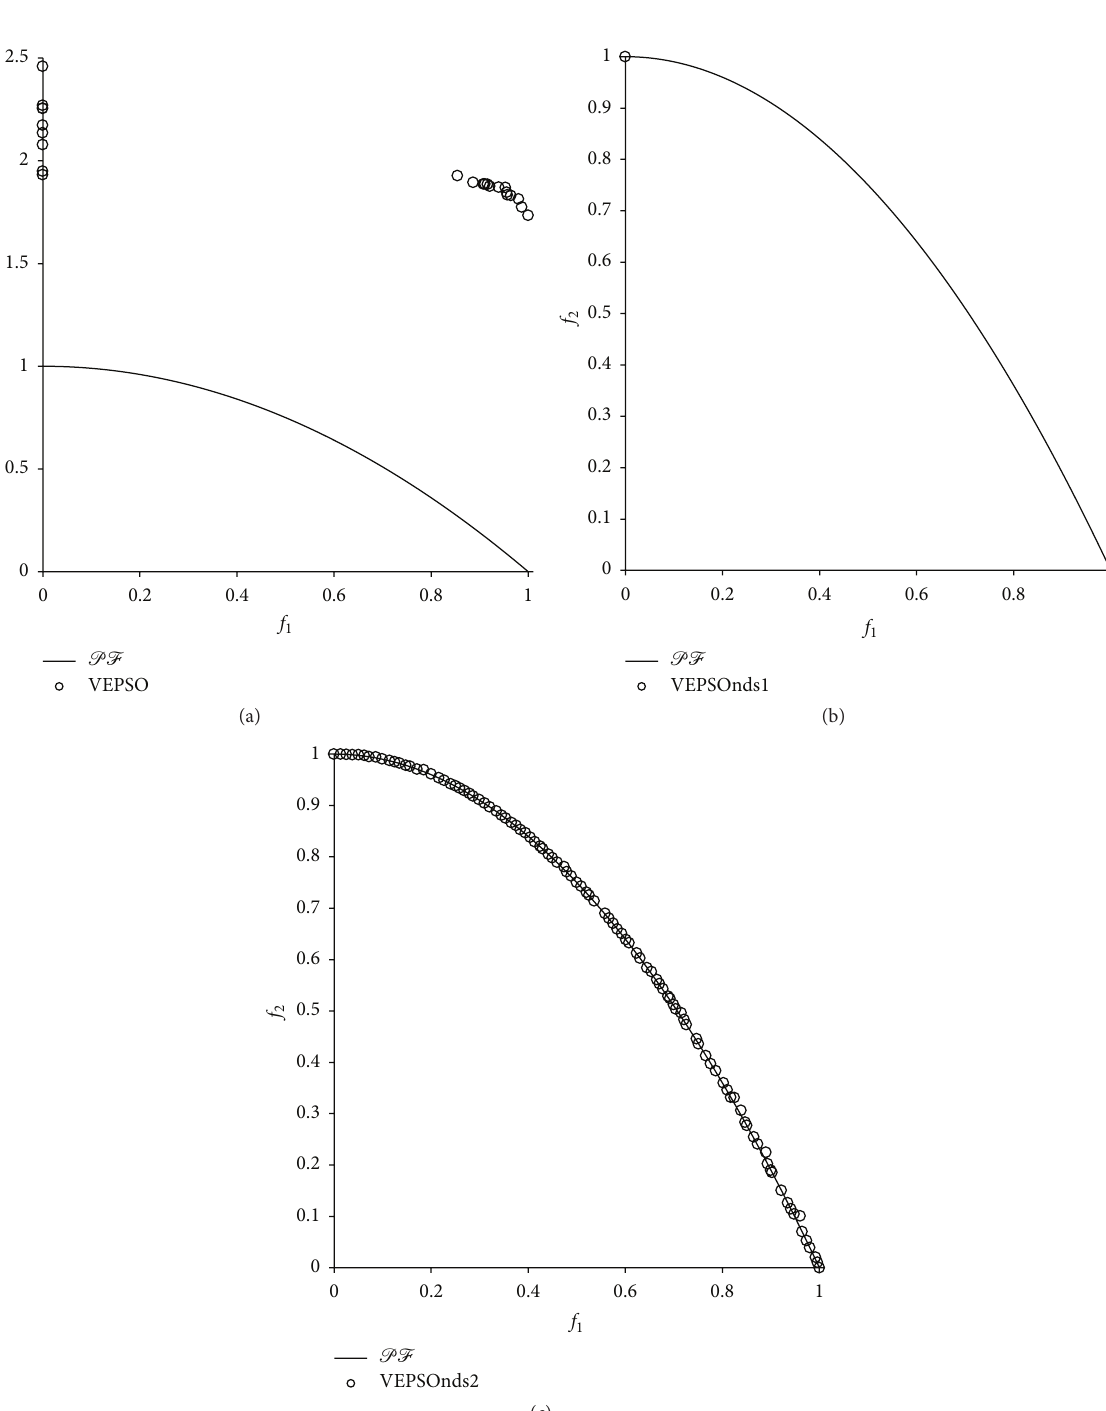
Figure 6: Plot of nondominated solutions returned by each algorithm for the ZDT2 test